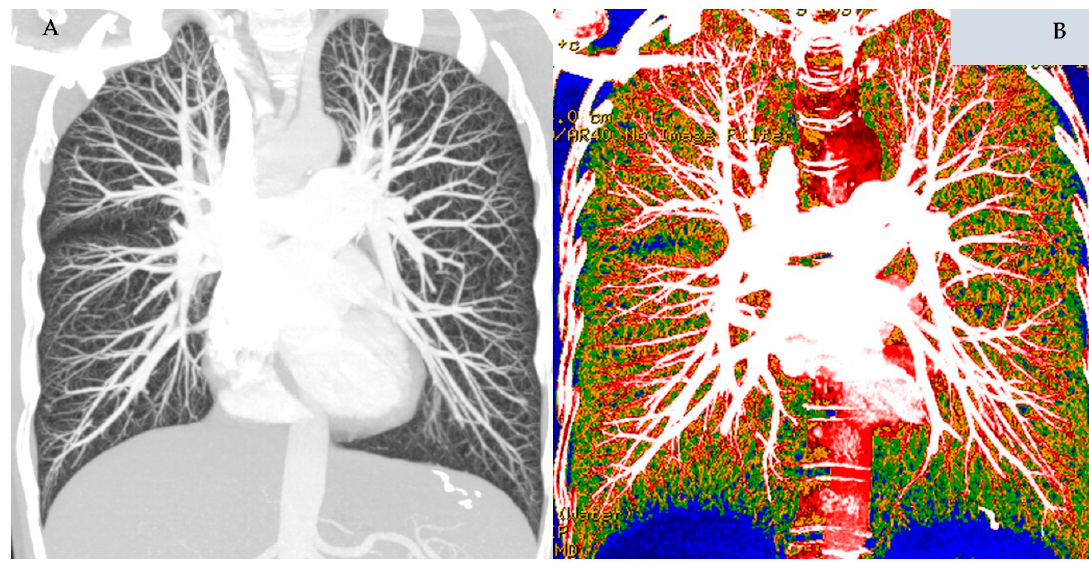
Figure 4. Coronal view of a dual-energy CT pulmonary angiography dataset from a normal female subject. Panel A is maximum intensity projection view. Panel B is colour-coded dual-energy overlay map.